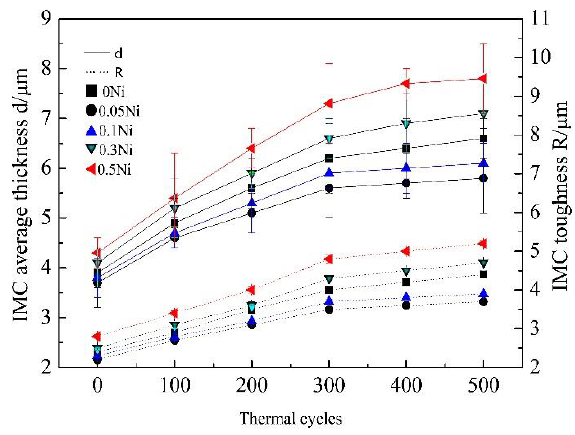
Figure 8. Relationship between Sn2.5Ag0.7Cu0.1RexNi / Cu solder joint interface area IMC layer roughness R , average thickness d, and thermal-cycle loading.